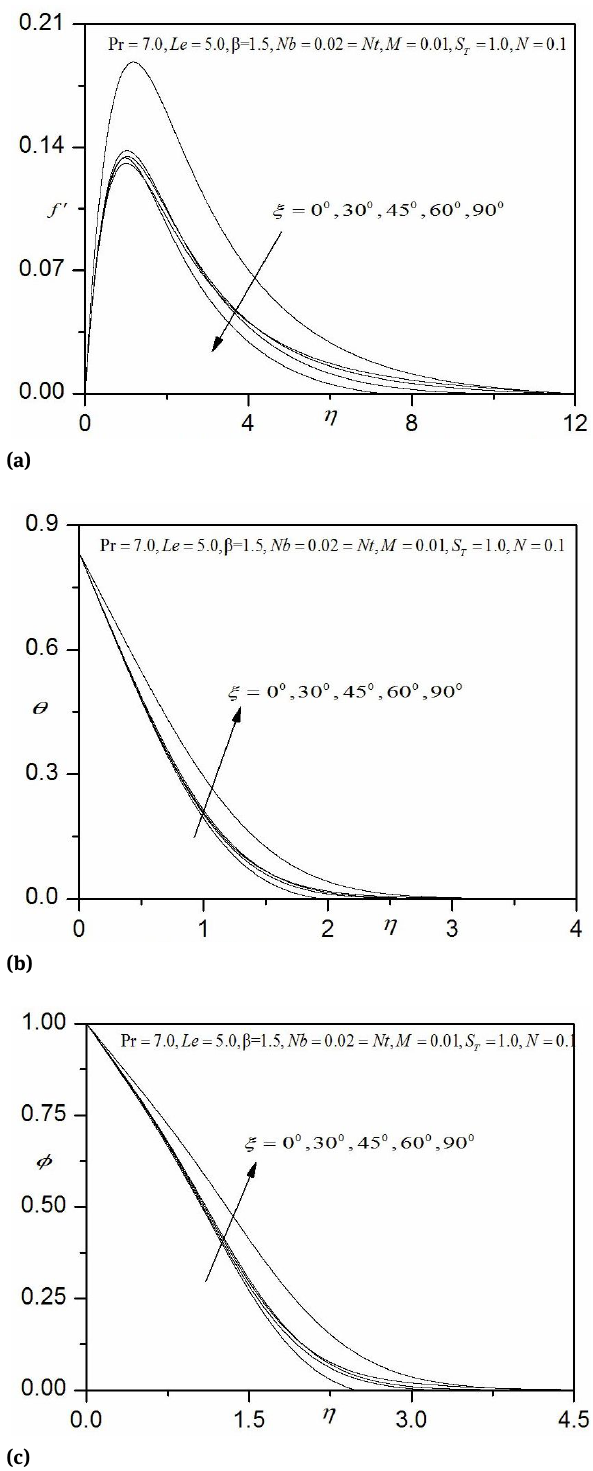
Fig. 11: Effect of ξ on (a) velocity profiles, (b) temperature profiles, (c) concentration